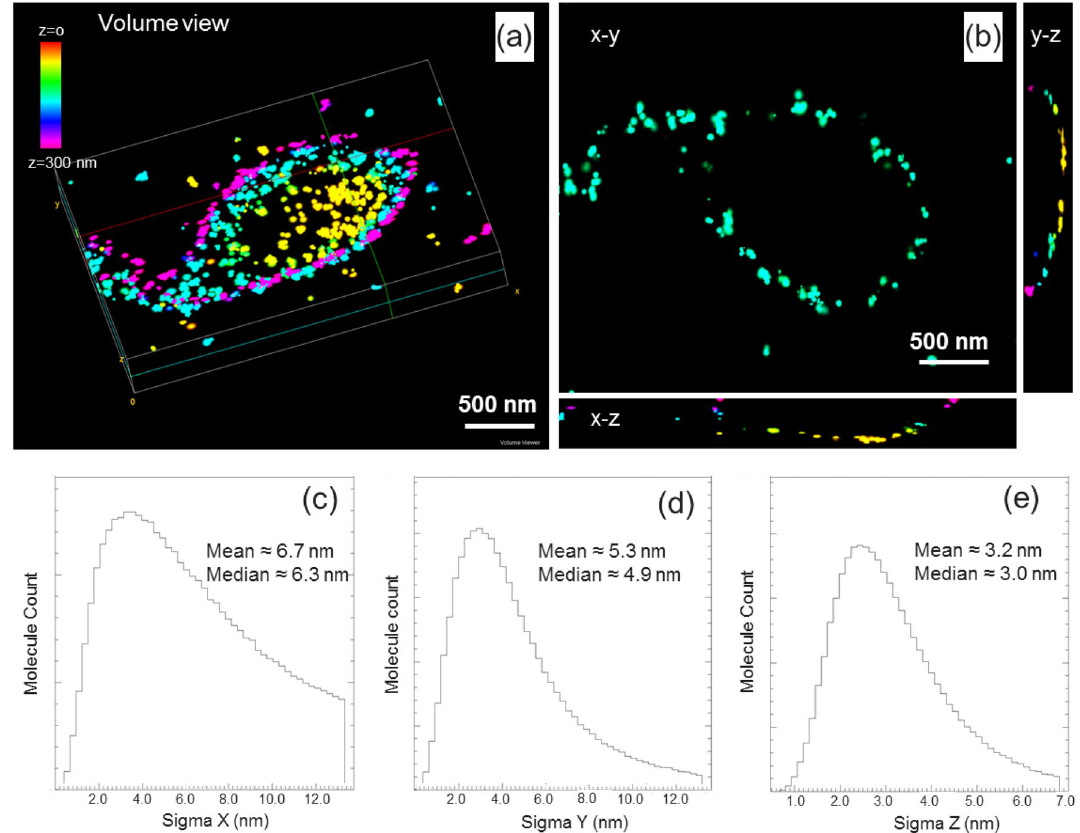
Figure 8. ( a , b ) 3D renderings of the outer mitochondrial membrane of the targeted U2OS cells. Several vantage points are shown to illustrate the nearly continuous nature of the outer membrane. Single molecule localization accuracies in x, y, z were shown in ( c – e ) as calculated by Peakselector. The cutoffs for Sigma X, Sigma Y, and Sigma Z were ~ 13 nm, ~ 13 nm, and ~ 7 nm, respectively. The pixel size of the imaging system is 133 That being said, current iPALM setups and procedures are much more complicated than other single-molecule SRM modalities, which places constraints on how samples are prepared and, correspondingly, how the correlative process must be carried out. In general, it is required that the regions of interest be re-located and re-imaged with EM after they have been imaged in iPALM first. In between iPALM and EM is a lengthy sequence of sample preparation steps including post-fixation, resin-embedding, and heavy metal staining. For obvious reasons, all the EM sample preparation steps that occur after iPALM imaging need to be done in a way that best preserves the sample structure. Another challenge faced by iPALM-CLEM is the development of sample preparation protocols that allow optimal performance of both imaging modalities. Strong fluorescence signal and low background are necessary for high quality iPALM imaging performance. Additionally, good photo-switching properties are required of the fluorescent probe to achieve single molecule localization 28 . For an optimal CLEM workflow, EM sample preparation protocols, including strong chemical fixation, dehydration/infiltration, and heavy metal staining, need to be considered carefully as to not degrade the SRM imaging conditions. In addition, alignment and co-registration of the two data modalities (iPALM and EM) with high accuracy in 3D space is vital. To this end, we have successfully created a correlative workflow in which iPALM imaging of immunolabeled U2OS cells is performed prior to the resin embedding process. The advantage to performing iPALM in the pre- embed phase is that it allows optimization of the fluorescence SRM imaging conditions with minimal consid- eration to the EM sample preparation that follows. We performed minimal membrane permeabilization during the sample immunolabeling to avoid cellular structure extraction as preferred in most EM sample preparation protocols. A major challenge in the latter steps of the workflow is the requirement of locating and aligning the same region of interest (ROI) between iPALM and SEM images. To overcome this issue, we first grow cells on pho- toetched round glass coverslips which have 200 alphanumerically labelled square regions arranged in a diamond pattern (Bellco Glass Inc. Part #: 1916–91,025) (Fig. 2a). The unique feature of these coverslips which makes them truly useful to this workflow is that the above described pattern is etched into the coverslips, making it possible